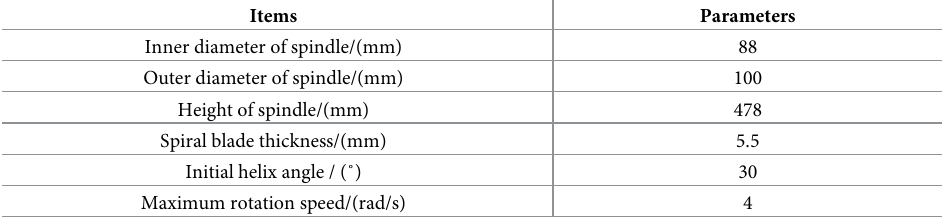
Table 2. Key design parameters of the trenching and fertilizing mechanism.